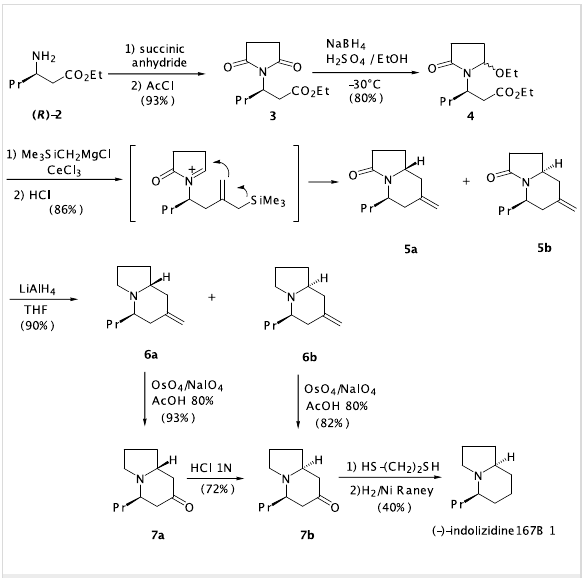
Scheme 2: Enantioselective synthesis of (-)-indolizidine 167B by intramolecular allylsilane- N -acyliminium